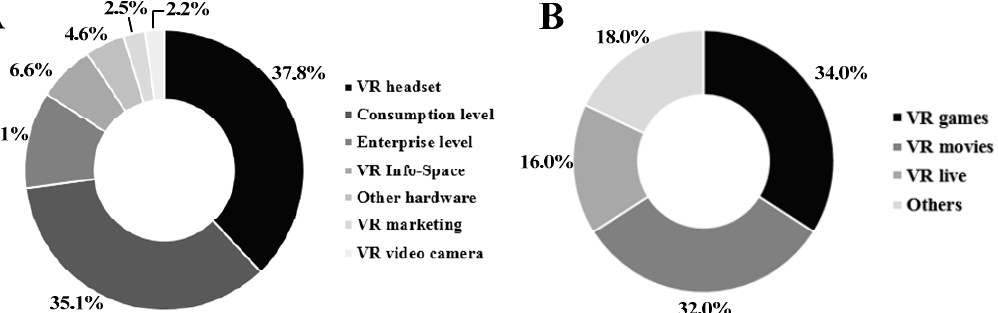
Figure 10. ( A , B ) Share of VR market segment in China in Figure 10. ( A-B ) Share of VR market segment in China in 2021.